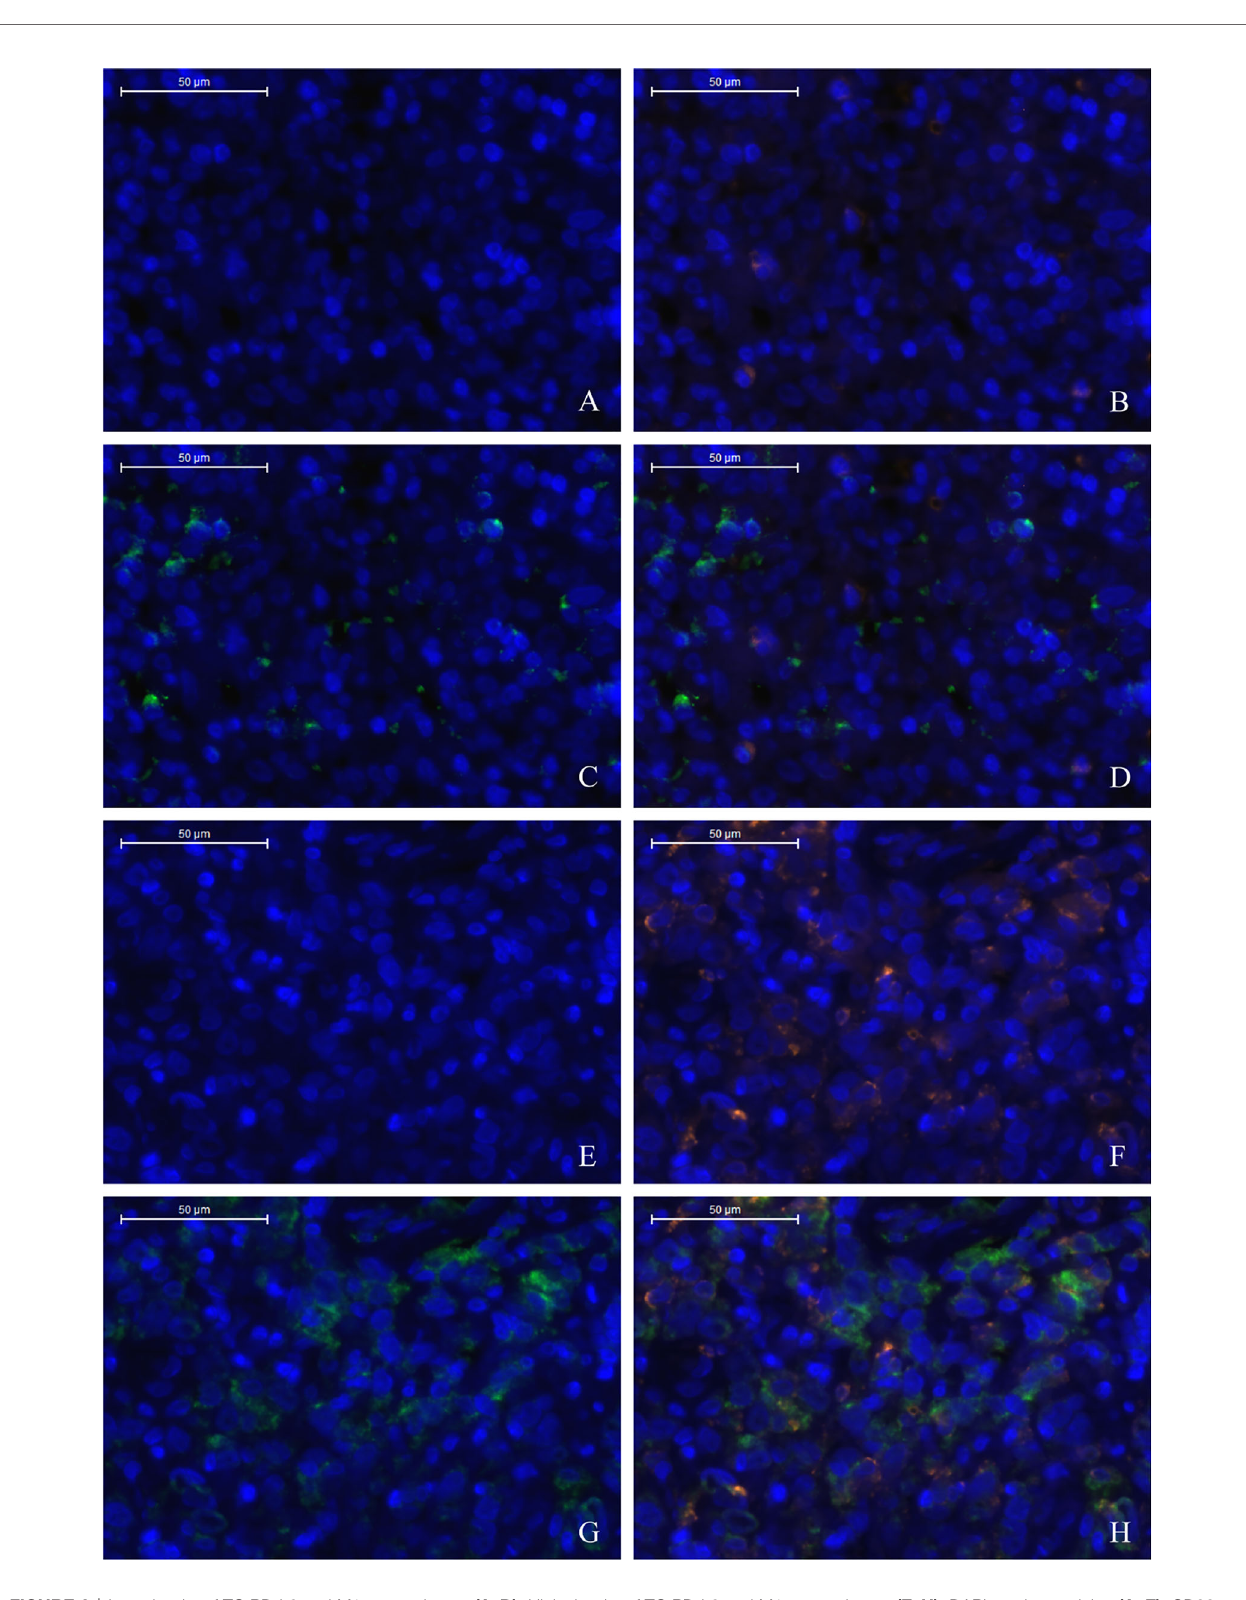
FIGURE 6 | Low density of TC PD-L2 and M1 macrophages (A – D) . High density of TC PD-L2 and M1 macrophages (E – H) . DAPI: nuclear staining (A, E) , CD86 staining (B, F) , PD-L2 staining (C, G) Merge, (D, H)